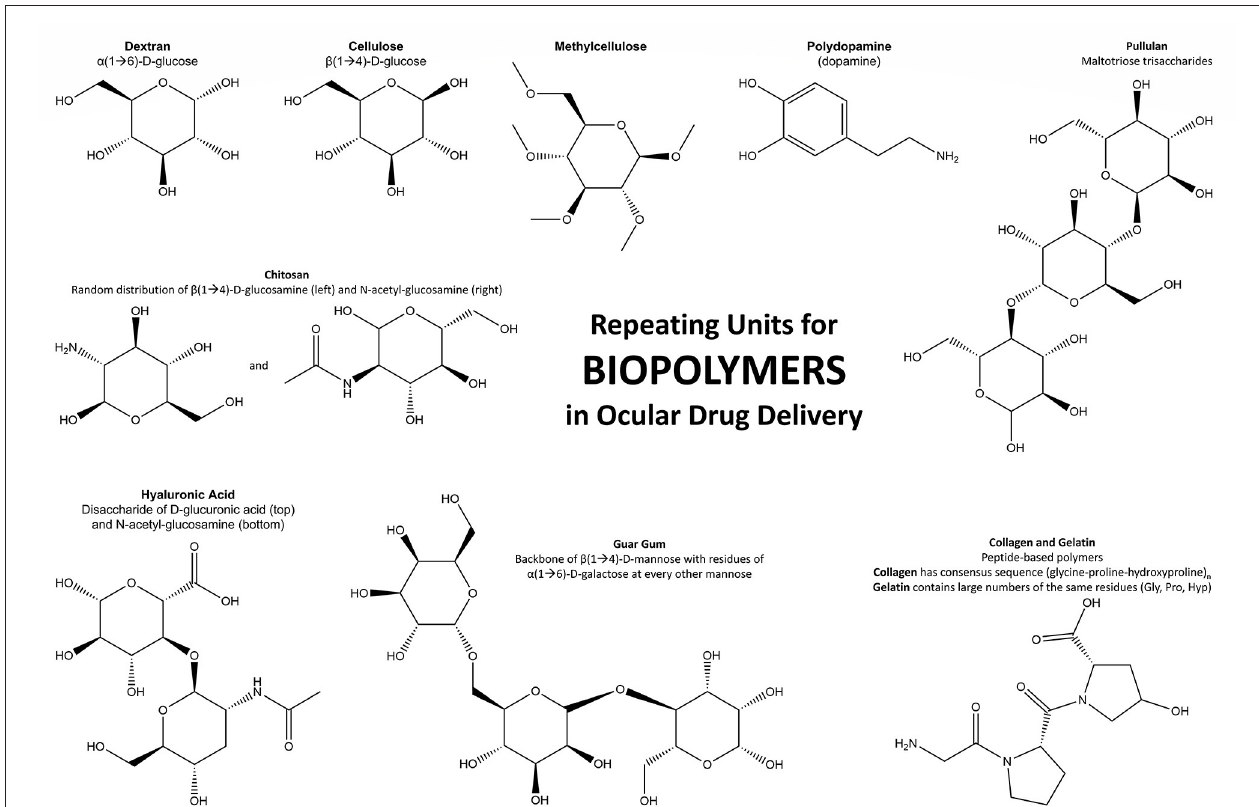
FIGURE 3 | Schematic of the repeating units that form the most noteworthy biopolymers used in ocular drug